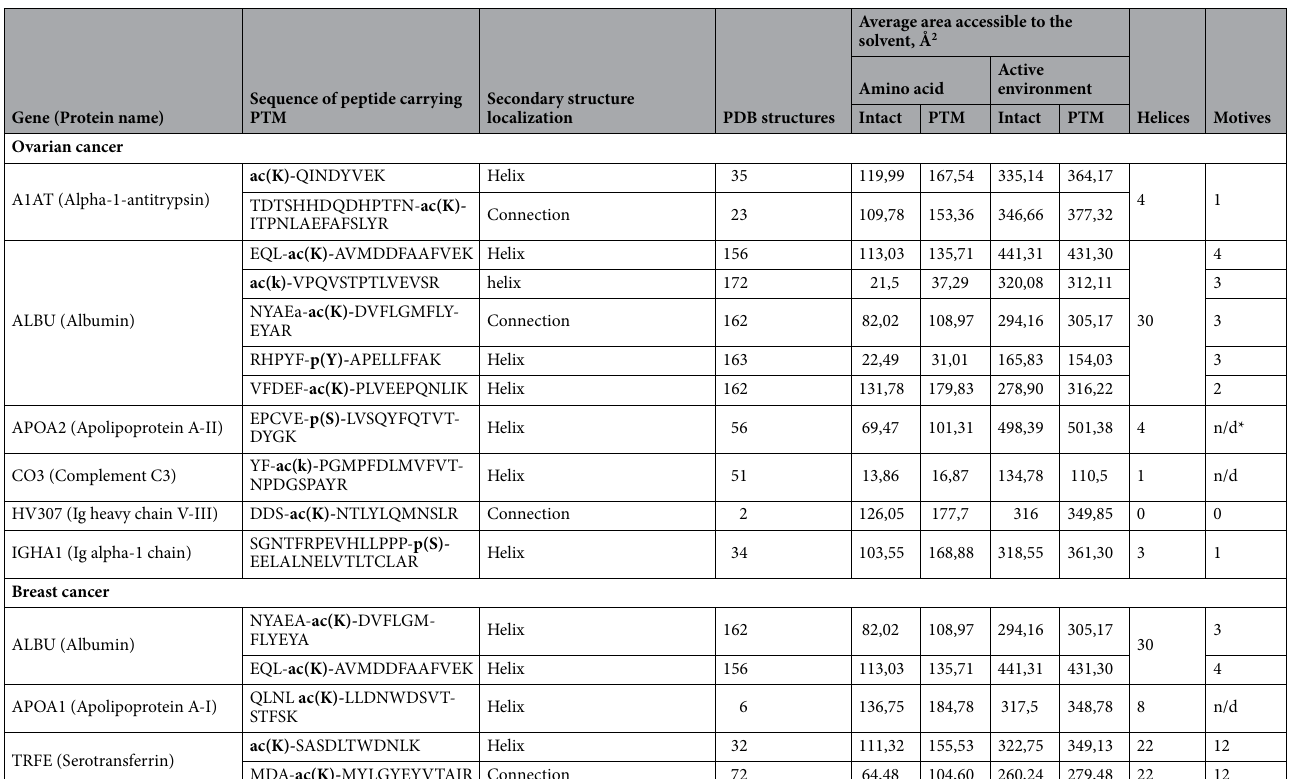
Table 2. Solvent accessible area alterations of amino acid residue and its active environment before and after modification (mounting of PTM) in breast and ovarian cancer-specific proteins. Bold values indicate the exact affected (modified) amino acid residue to attract readers’ attentionand for easier navigation. n/d* – motives with interacting helices are not found; PDB structures – the number of PDB structures matching